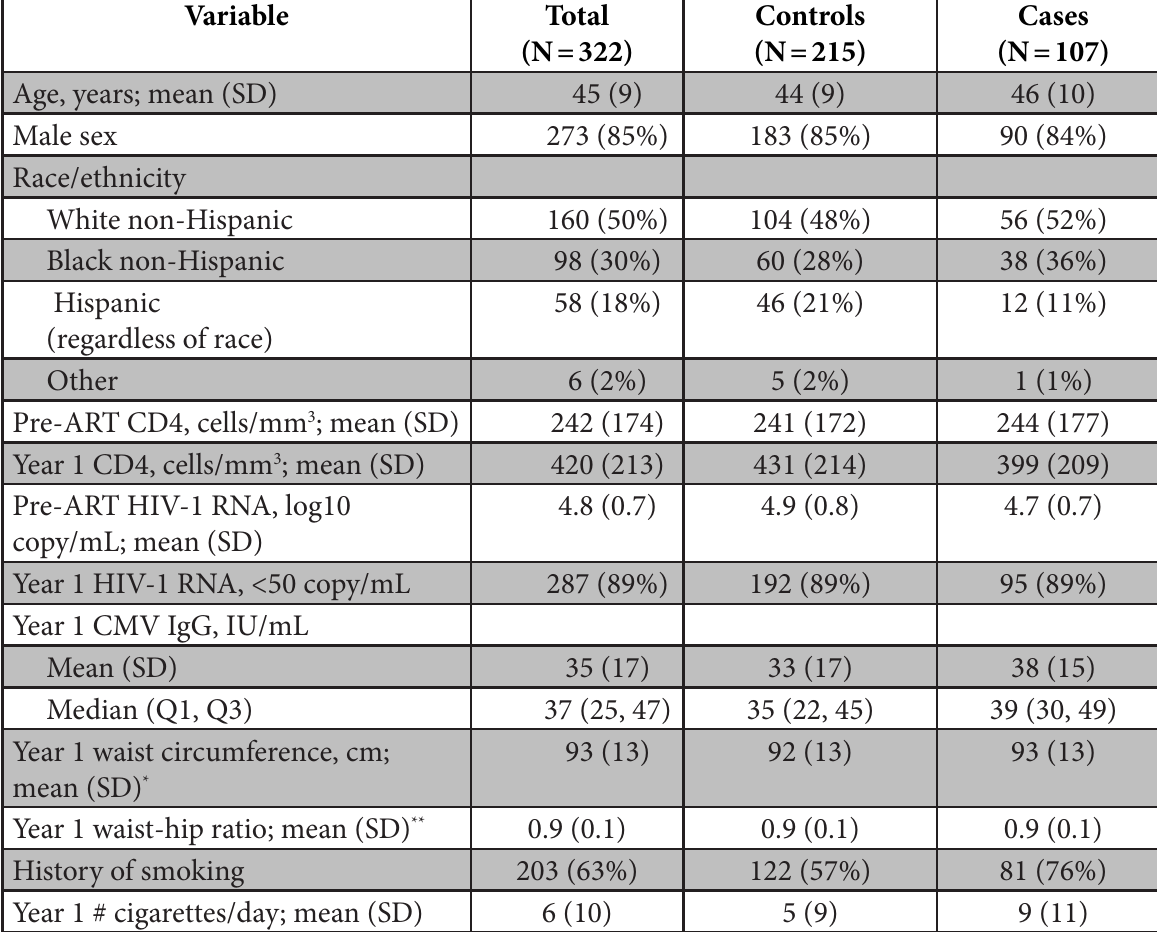
Table 1. Demographic Characteristics of Cases and